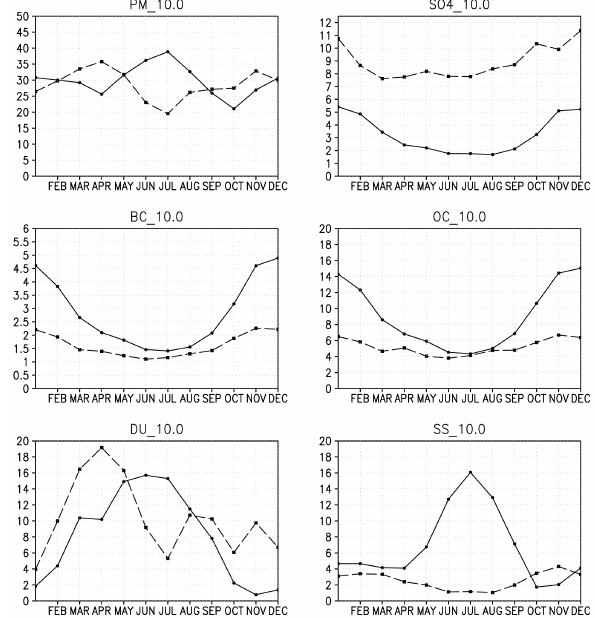
Fig. 8. Monthly mean surface PM 10 . 0 in units µgm − 3 and contri- butions to it from different aerosol species for China (dashed line) and India (solid line), four-year average (2006–2009).